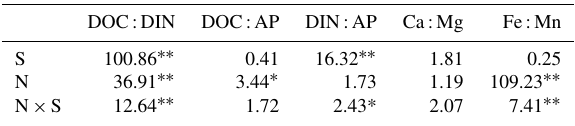
Table 1. The concentrations of soil organic carbon (SOC,gkgsoilaggregate − 1 ) , total nitrogen (gkgsoilaggregate − 1 ) ,